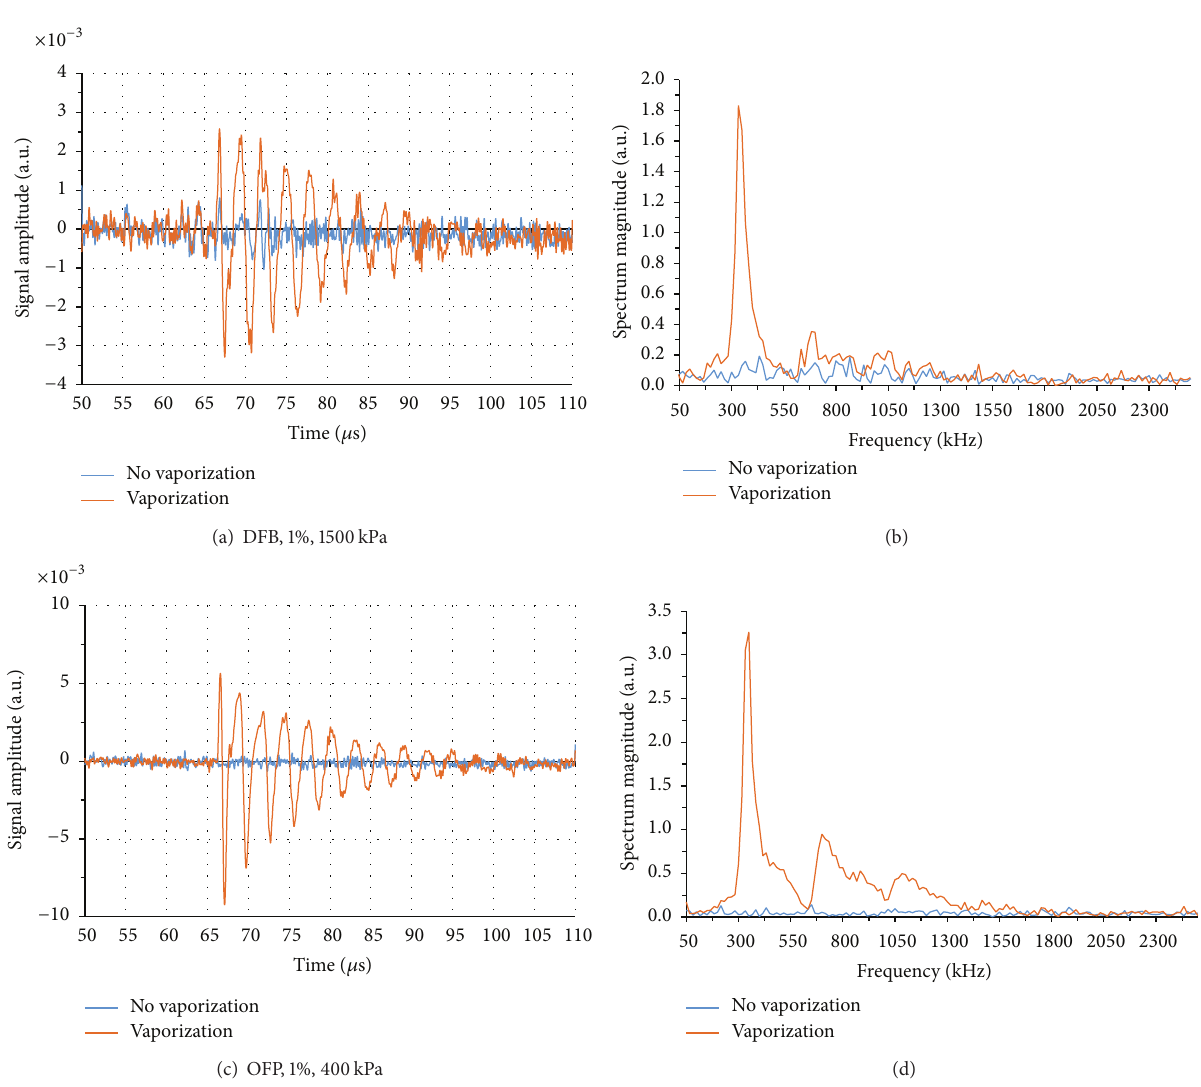
Figure 9: Signals produced by individual droplets vaporizing in the received transducer’s focus manifest as exponentially decaying sinusoids with very narrowband frequency content. Examples of (a) DFB droplet vaporization, (b) the associated frequency spectrum, and (c) and (d) OFP droplets oscillating at similar frequency produce larger amplitude oscillations even when exposed to significantly lower incident pressure as a result of greater droplet volatility. In all graphs, the blue trace shows the preceding pulse that did not produce a droplet vaporization event for the same sample and pulse pressure. Reproduced from [93] with permission from the Institute of Physics in Engineering and